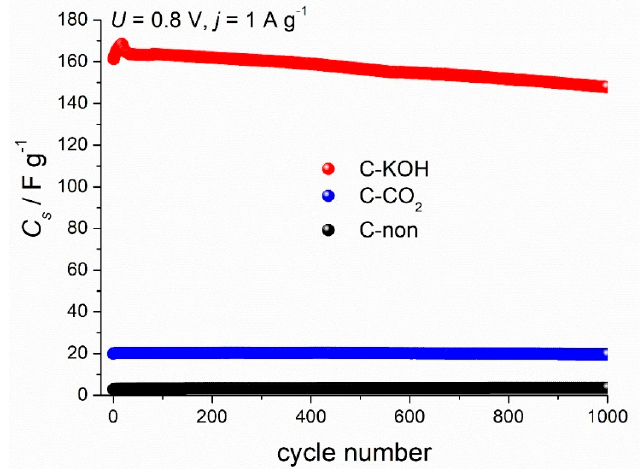
Figure 7. Electrochemical performance of C–KOH activated carbons; 6 M KOH electrolyte; GCD measured at 1 A g − 1 and 0.8 V cell voltage. GCD measured at 1 A g − 1 and 0.8 V cell